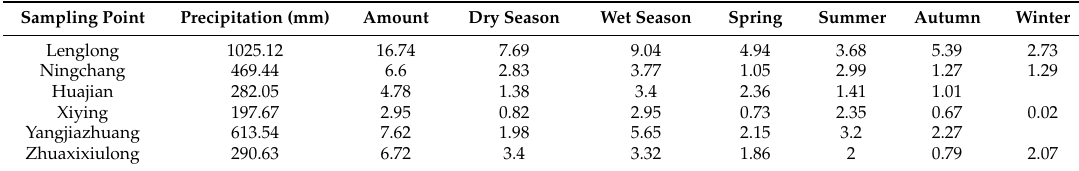
Table 6. The wet deposition flux of the nitrogen element (mg / dm 2 ).